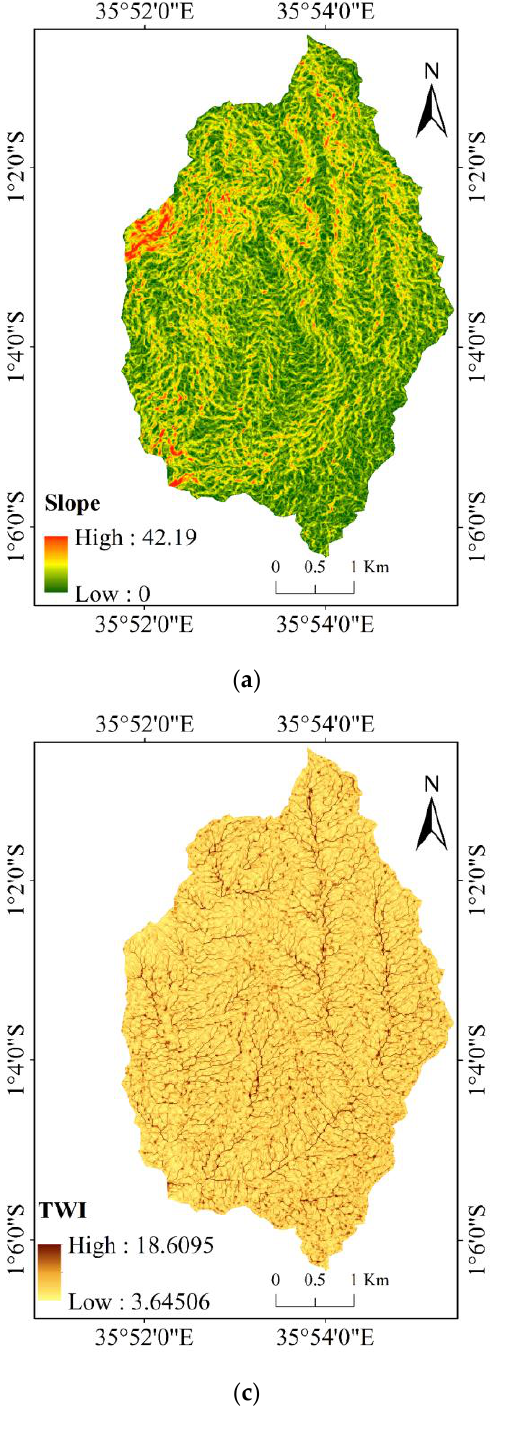
Figure 4. Gully erosion conditioning factors: ( a ) slope (percent), ( b ) curvature, ( c ) topographic wetness index (TWI) and ( d ) distance to stream/channel.